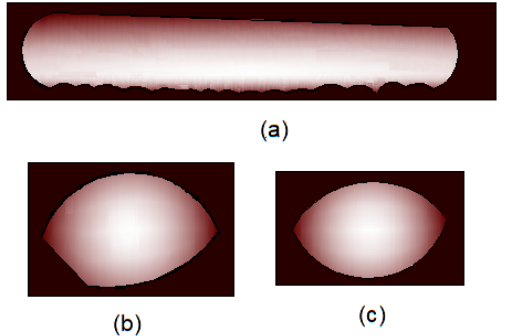
Figure 6. Melting of PCM in the horizontal cylinder, adapted from Sparrow and Geiger [66]: ( a ) longitudinal view of the fixed solid, ( b ) transversal view of the fixed solid, and ( c ) transversal view of close contact melting.